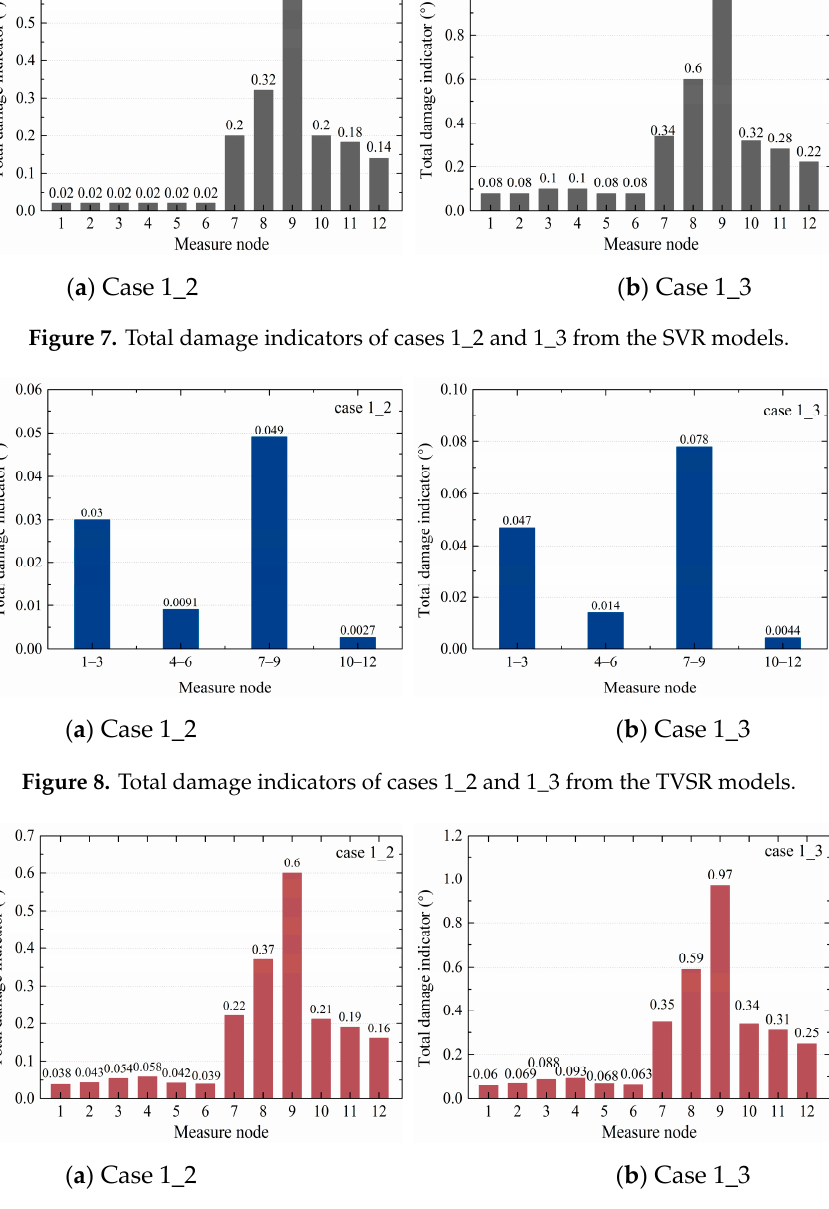
Figure 9. Total damage indicators of cases 1_2 and 1_3 from the TVSTR models.